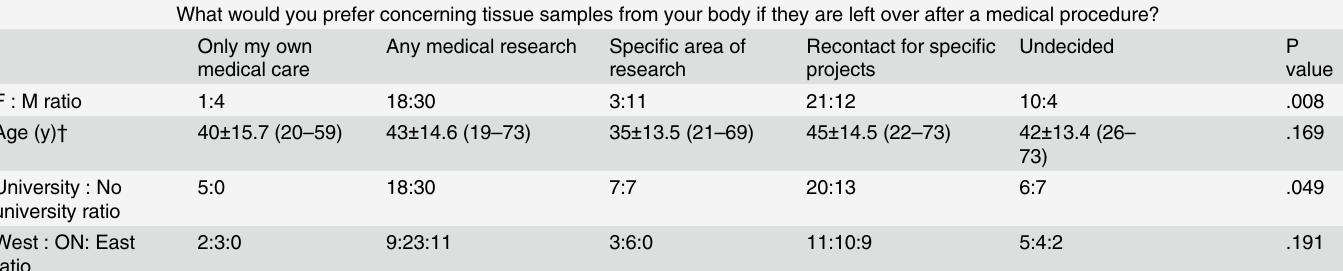
Table 5. Data and Sample Sharing Model Preferences versus Demographic Characteristics of Survey